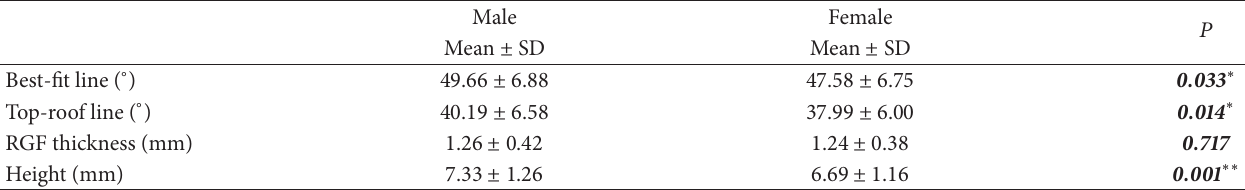
Table 2: The articular eminence and RGF thickness measurements according to age groups.